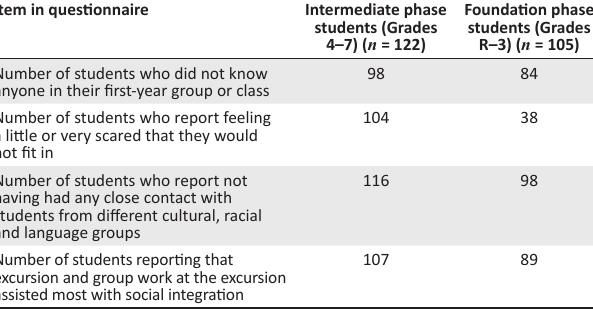
TABLE 1: Extracts of student responses from questionnaire